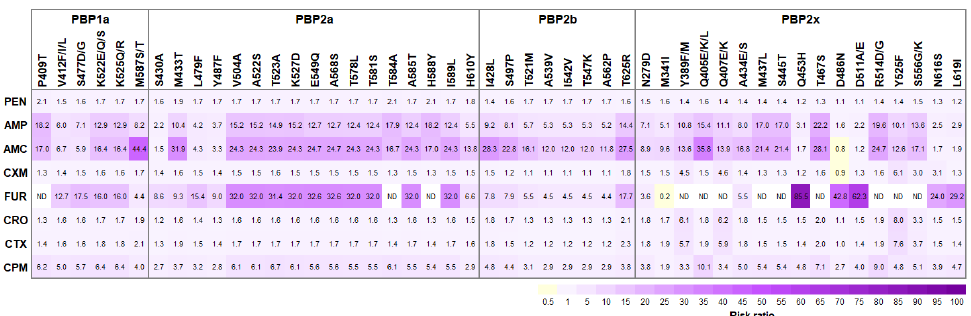
Figure 3. Risk ratio (RR) between candidate PBPs substitutions and β -lactams-non-susceptible phenotypes. Note only those 47 candidate substitutions with significantly differentiated β -lactams-susceptible and β -lactams-non-susceptible isolates (>50%) and found in β -lactams-non-susceptible S. suis isolates with high frequency (>70%), and M341I in 339 STMK motif of PBP2x, are listed. Positive associations (RR > 1) are visualized in purple blocks and negative associations (RR < 1) in yellow blocks. Color intensity of the text labels represents proportional to the risk ratio. AMC, Amoxicil- lin/Clavulanic acid; AMP, Ampicillin; CPM, Cefepime; CRO, Ceftriaxone; CTX, Cefotaxime; CXM, cefuroxime; FUR, Ceftiofur; PEN, Penicillin. ND, the risk ratio analysis could not be determined, due to none of the FUR-non-susceptible S. suis isolates without PBP substitutions.